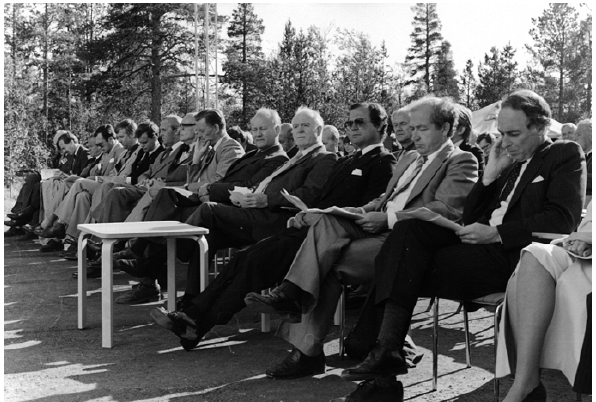
Figure 2. The inauguration ceremony is ready to start outdoors at the Kiruna site. From right in first line: MacFarlane SRC, Minis-